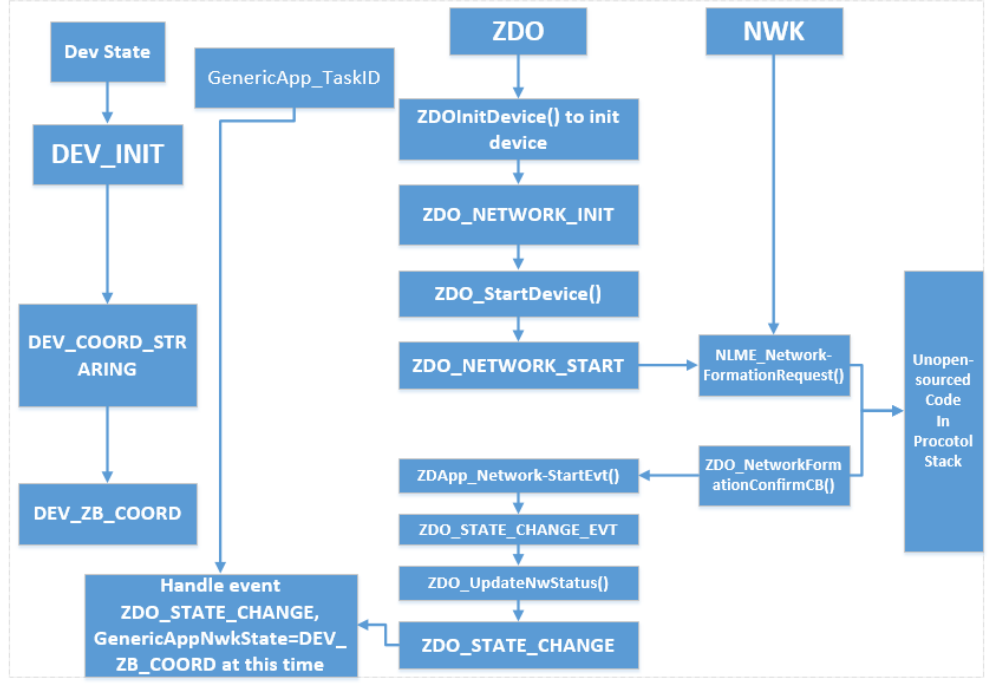
Figure 12. Coordinator networking process.